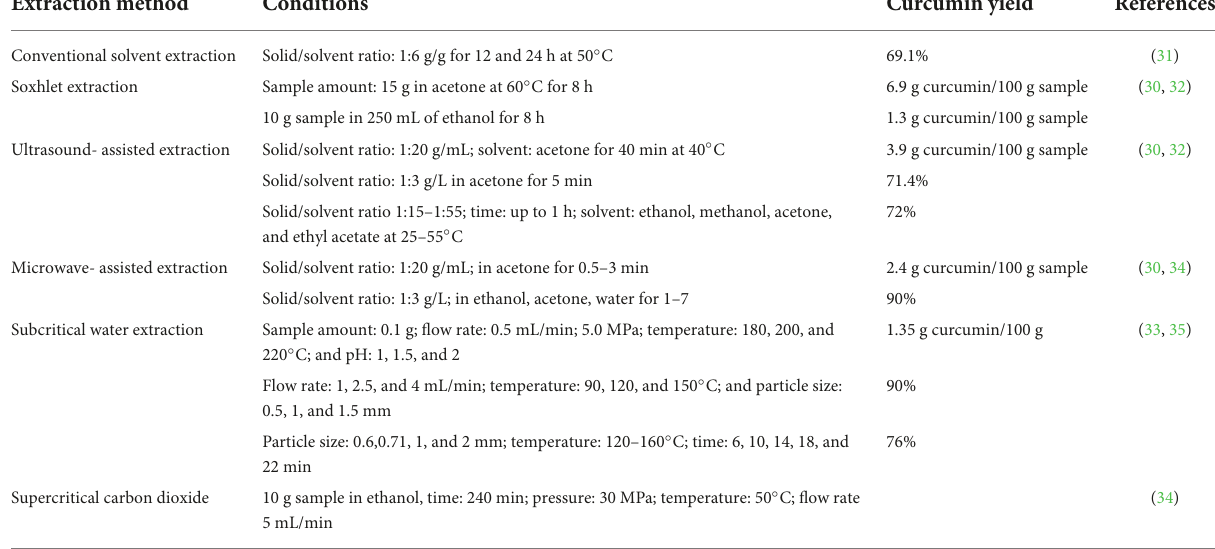
TABLE 1 List of extraction methods for bioactive compounds in